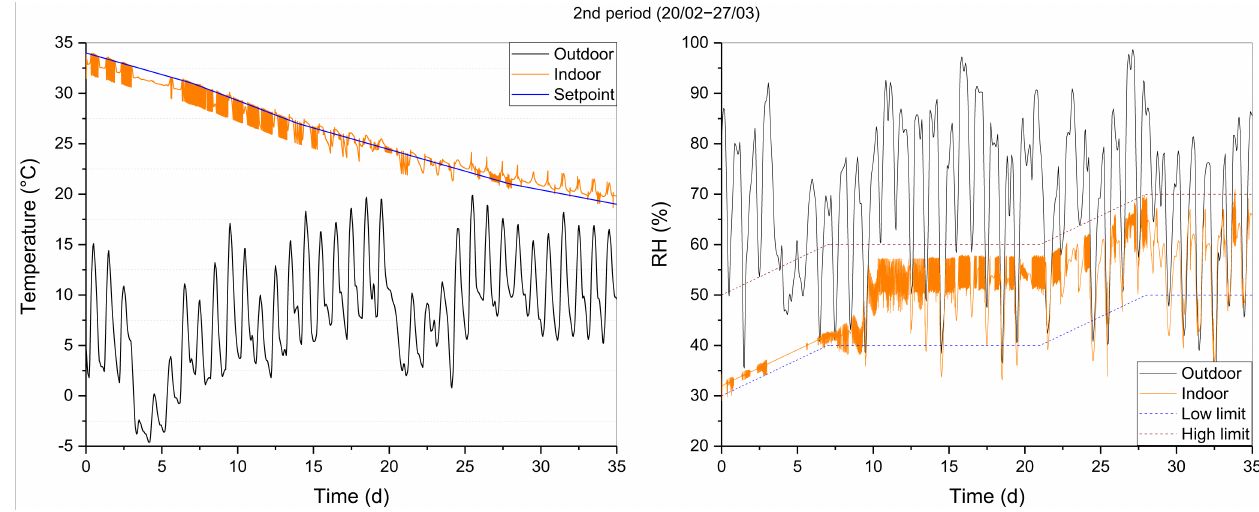
Figure 6. Temperatures and relative humidity variation during the 2nd production period (20.02–27.03).